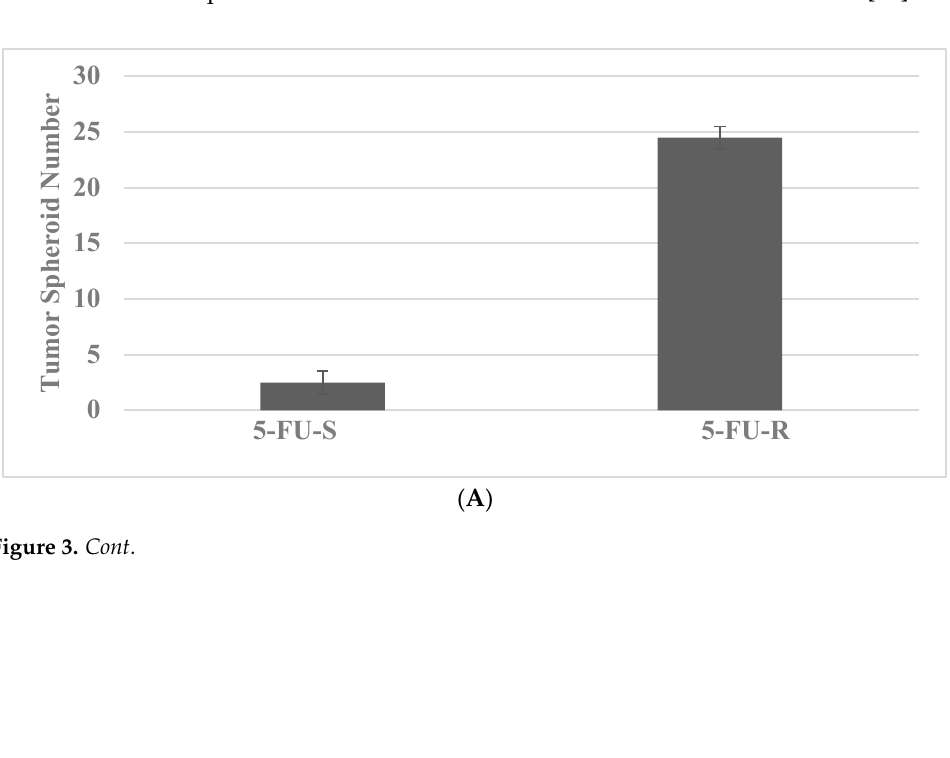
Figure 2. Status of tumor spheroid formation and stem cell marker expression in 850 MIN COL model. ( A ) The tumor spheroid number is increased in the resistant SUL-R phenotype relative to the sensitive SUL-S phenotype. ( B ) The expression of CD44, CD133 and c-Myc is increased in the resistant SUL-R phenotype relative to the sensitive SUL-S phenotype. SUL, sulindac; CD44, cluster of differentiation 44; CD133, cluster of differentiation 133; c-Myc, cellular Myc. The data presented in Figure 3A,B illustrate the expression of TS and CD44, CD133 and c-Myc in the Mlh 1 /1638N COL cells, a model for HNPCC. The 5-FU-R stem cells exhibit increased expression of the stem cell markers relative to the 5-FU-S cells [28].